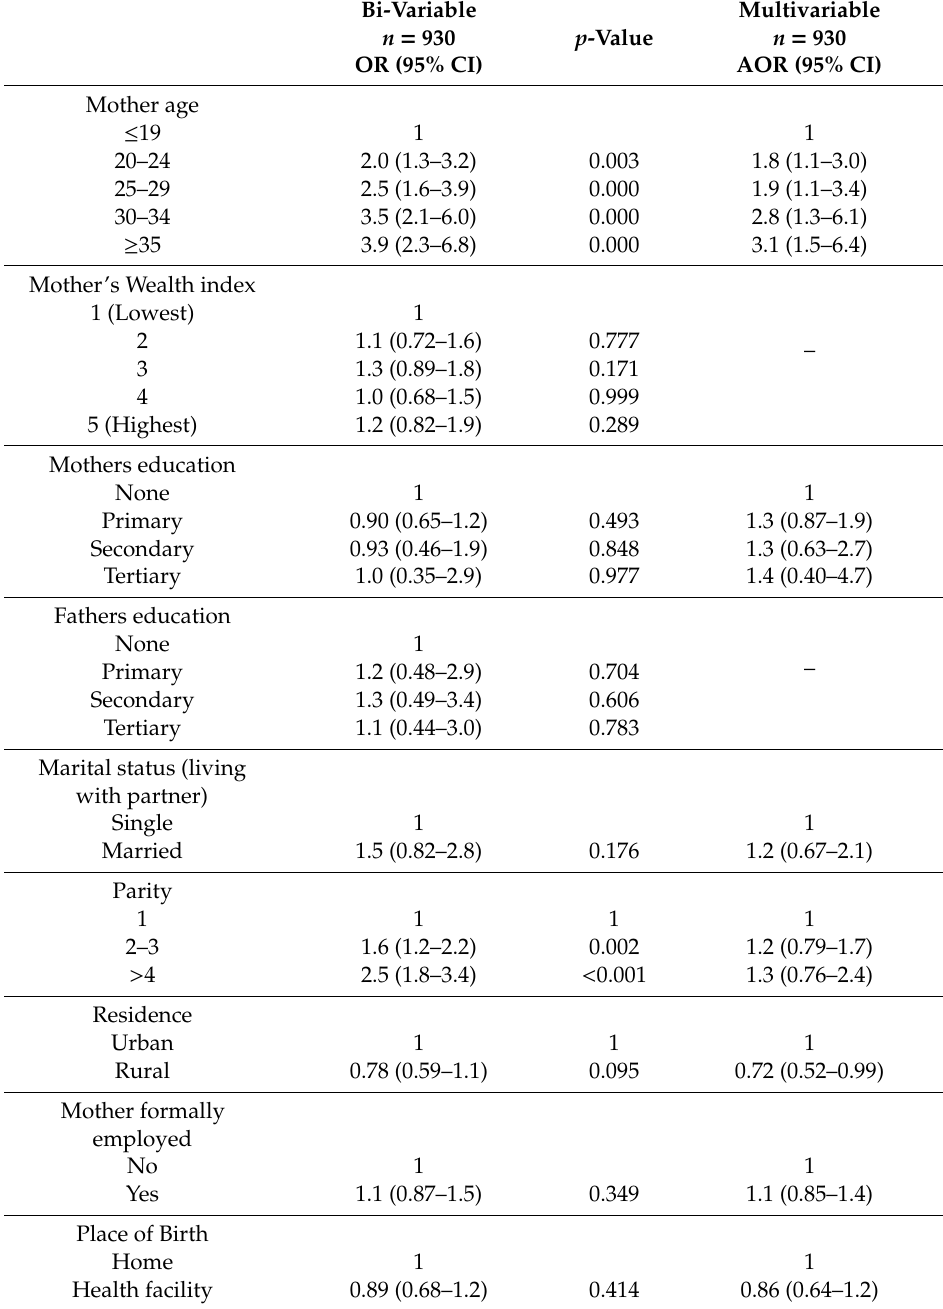
Table 5. Factors associated with mothers being the key decision makers on when to initiate breastfeeding in the Lira district, Northern